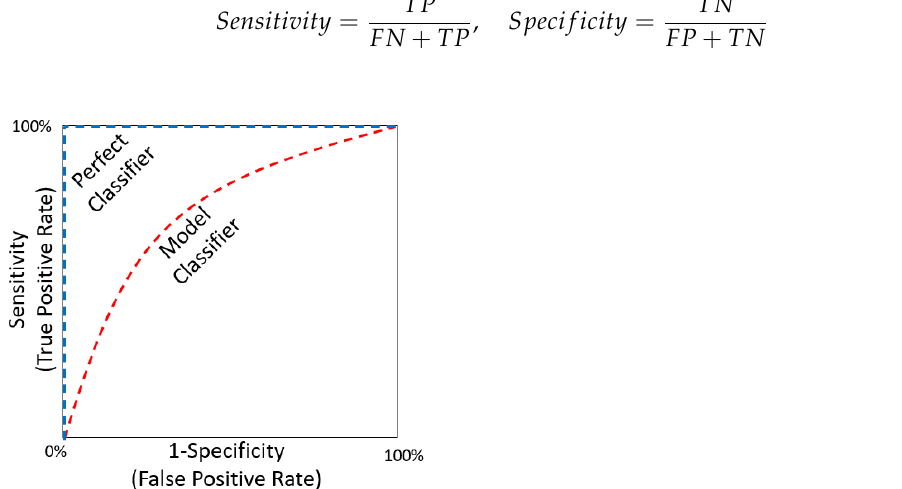
Figure 6. Example of minimizing the distance from maximum theoretical threshold value of point A to any point on the classifier’s ROC.